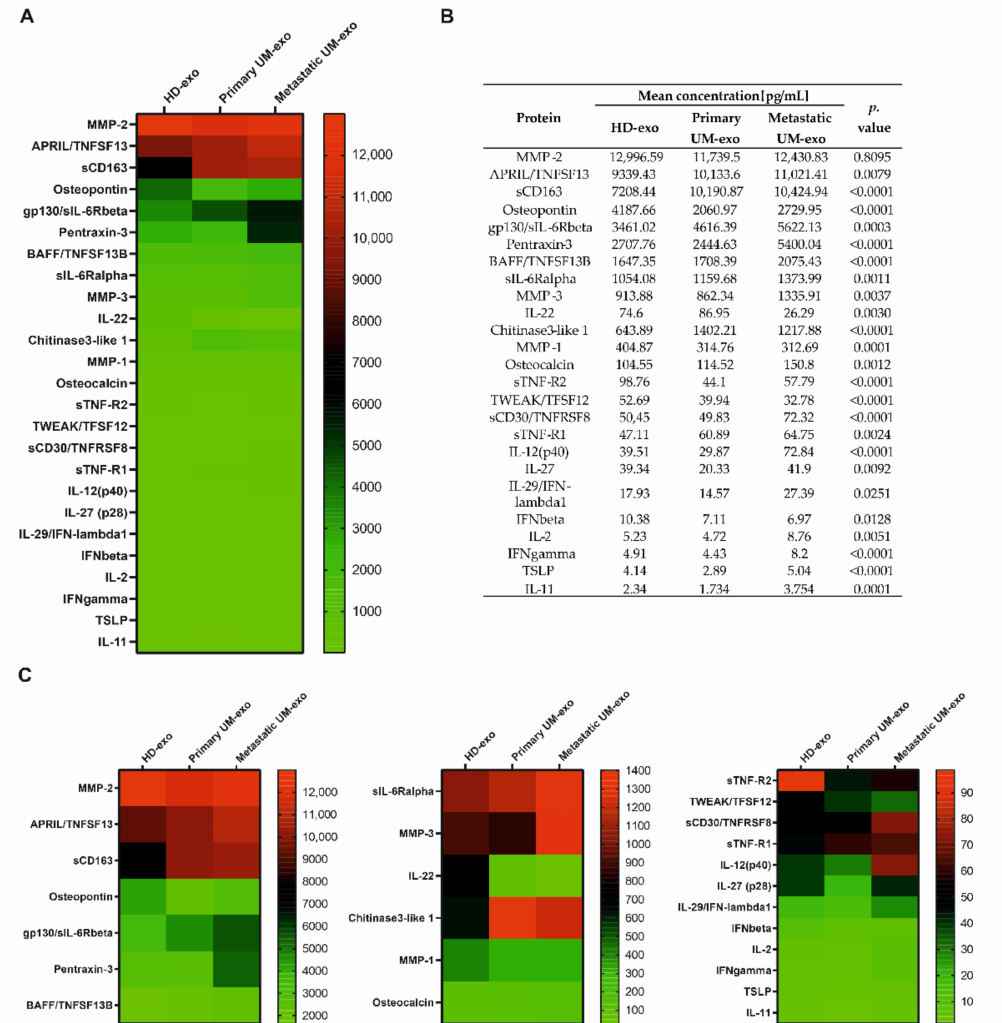
Figure 3. Immunomodulatory protein cargo of exosomes from healthy donors and UM patients. All the concentrations are displayed in (pg/mL), only the proteins effectively detected are shown. ( A ) Heatmap representing mean concentrations of all the analyzed cytokines in HD-exo, primary UM- exo and metastatic-exo groups; ( B ) table showing mean concentrations and p -values indicating the statistical significance; ( C ) to better visualize the differences in cytokine concentrations, the heatmap was divided into three panels with concentration range: 13,000–2000 pg/mL, 1400–100 pg/mL, 100–0 pg/mL. The p -value was calculated based on one-way ANOVA (data with normal distribution) or Kruskal–Wallis test (samples without normal